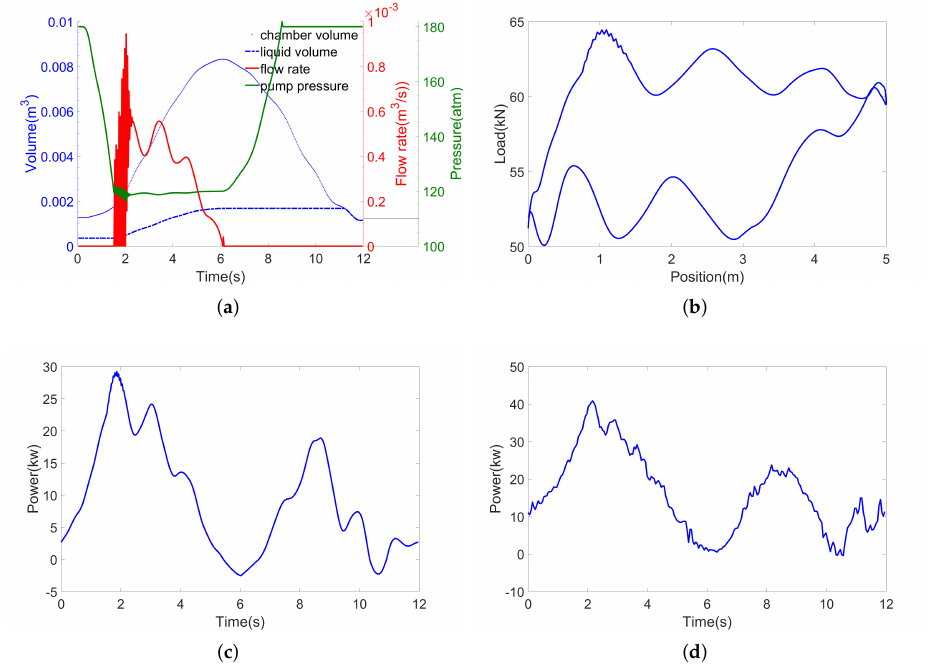
Figure 9. Gas affected working state. ( a ) Pump simulation. ( b ) Generated DC. ( c ) Generated MPC. ( d ) Actual MPC.